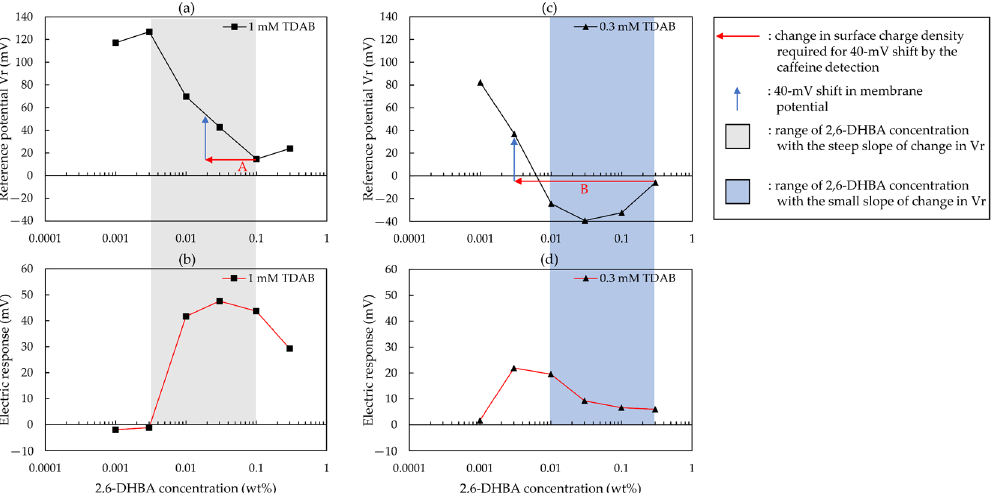
Figure 10. Relationship between reference potential and response to caffeine: ( a ) change in reference potential for the 1 mM TDAB membrane; ( b ) change in electric response for the 1 mM TDAB membrane; ( c ) change in reference potential for the 0.3 mM TDAB membrane; and ( d ) change in electric response for the 0.3 mM TDAB membrane.